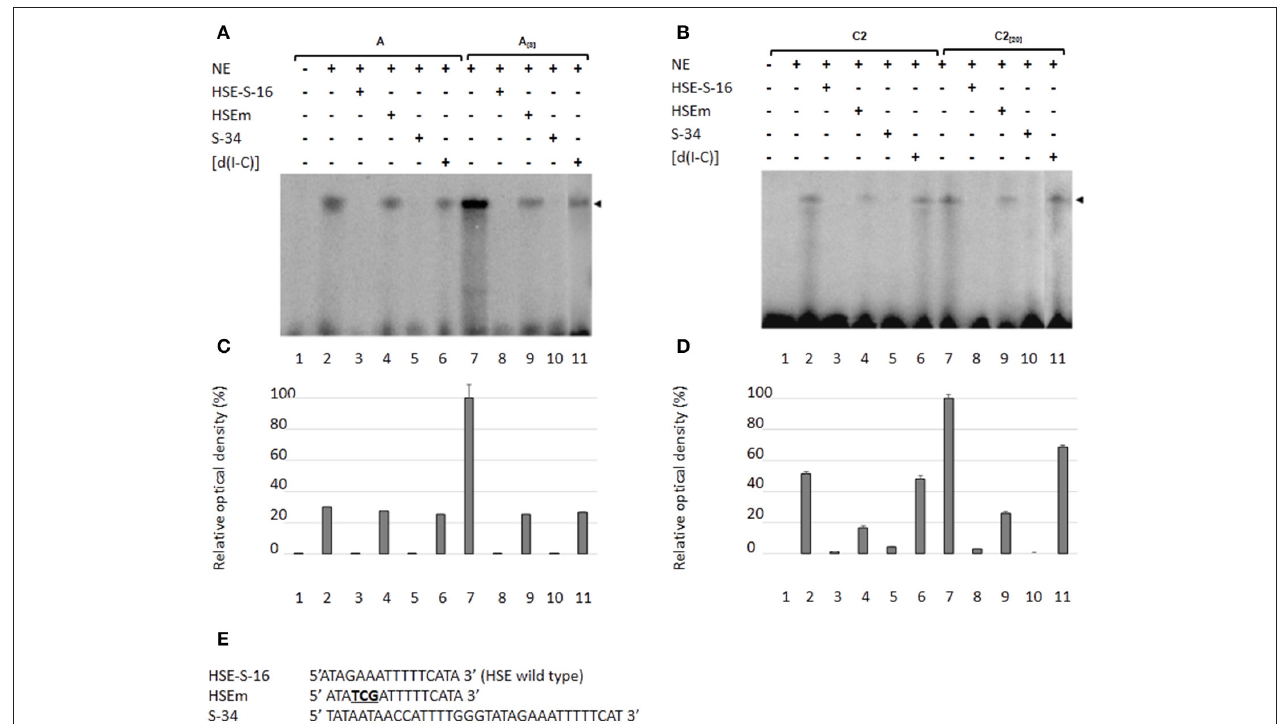
FIGURE 4 | Nuclear protein binding with the putative HSE element of the EhPgp5 gene core promoter. Gel shift assays were performed with 20 µ g of NE from clones: (A) A and A [8] , (B) C2 and C2 [20], 1 ng of [ γ - 32 P]-radiolabeled double-stranded fragment of different unlabeled oligonucleotides (150-fold molar excess). Lane 1, free probe; lanes 2 and 7, no competitor; lanes 3 and 8 specific competitor unlabeled straight (150-fold molar excess); lanes 4 and 9, specific competitor with the HSE mutated at the repeated GAA; lanes 5 and 10, specific competitor containing the CdxA, YY1, and HSE consensus sequences; lanes 6 and 11 unspecific competitor (350-fold molar excess of poly [d(I–C)]). Arrowheads indicate the specific complexes formed. (C,D) Densitometric analysis of DNA-binding interaction with NE